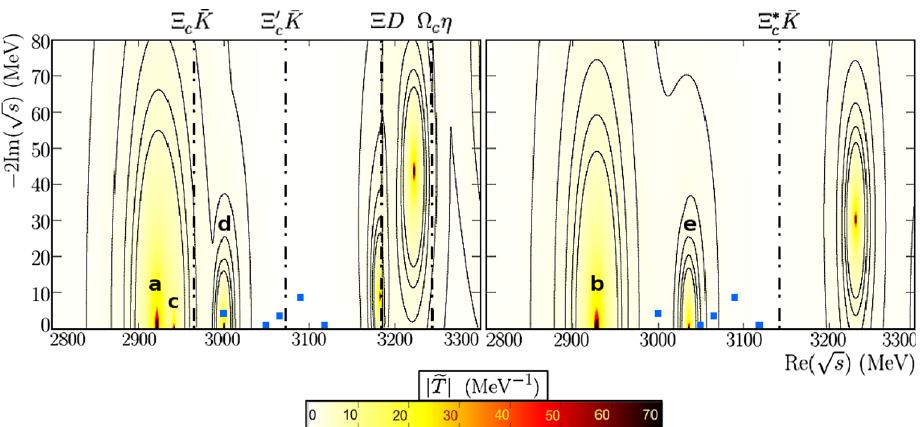
Fig. 2 (cid:2) c and (cid:2) ∗ c states obtained within the scheme of Ref. [38] using α = 1 . 16. The left (right) plot shows the states dynamically generated for J = 1 ( J = 3 ). The dotted blue points are the experimental obser- 2 2